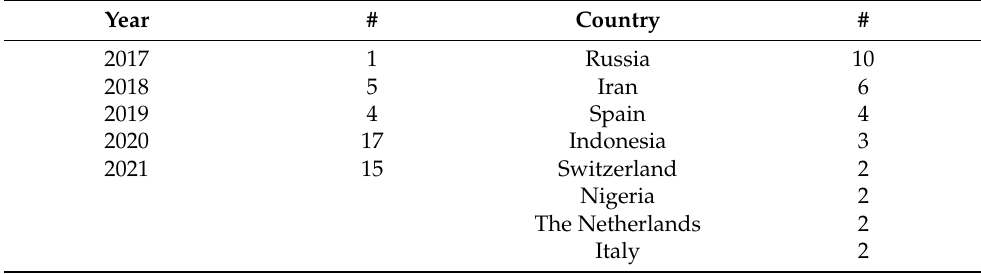
Table 1. Publication year and country. Sources: WOS &